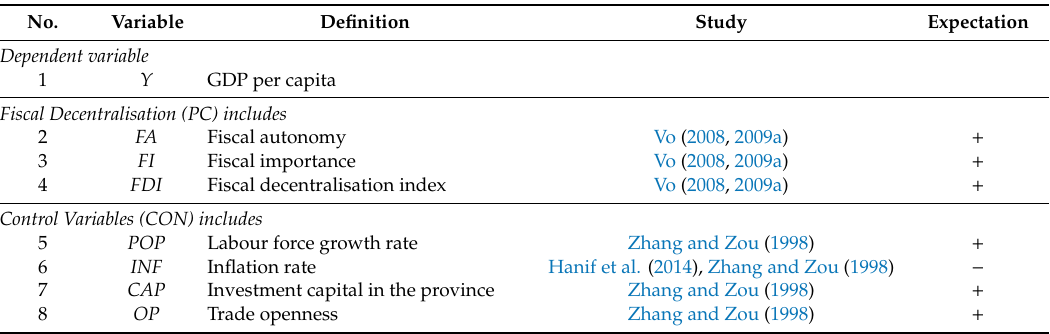
Table 1. Summary of variables used in the